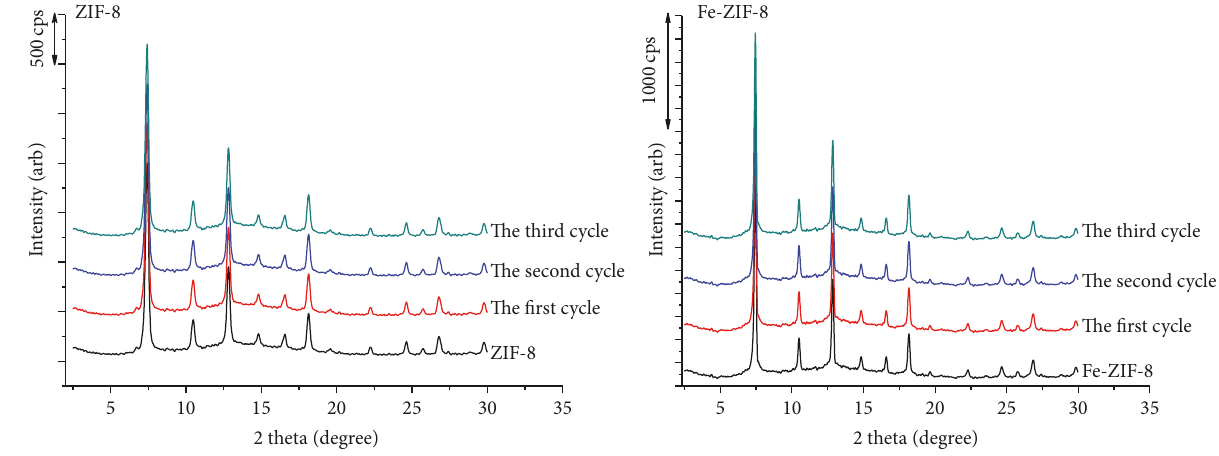
Figure 14: The XRD patterns of ZIF-8 and Fe-ZIF-8 adsorbents after the three